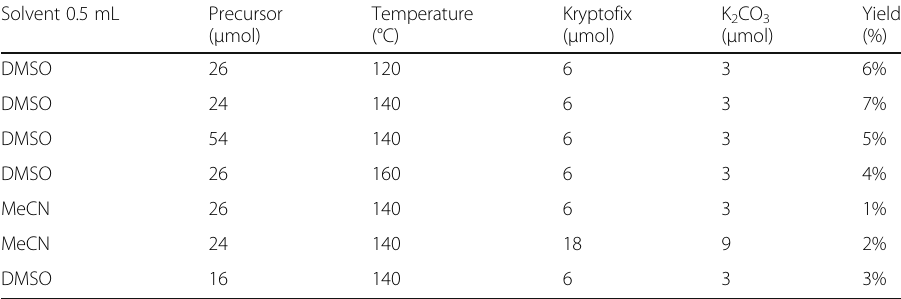
Table 1 Optimization of reaction conditions for radiosynthesis of [ 18 F] 3 Solvent 0.5 mL